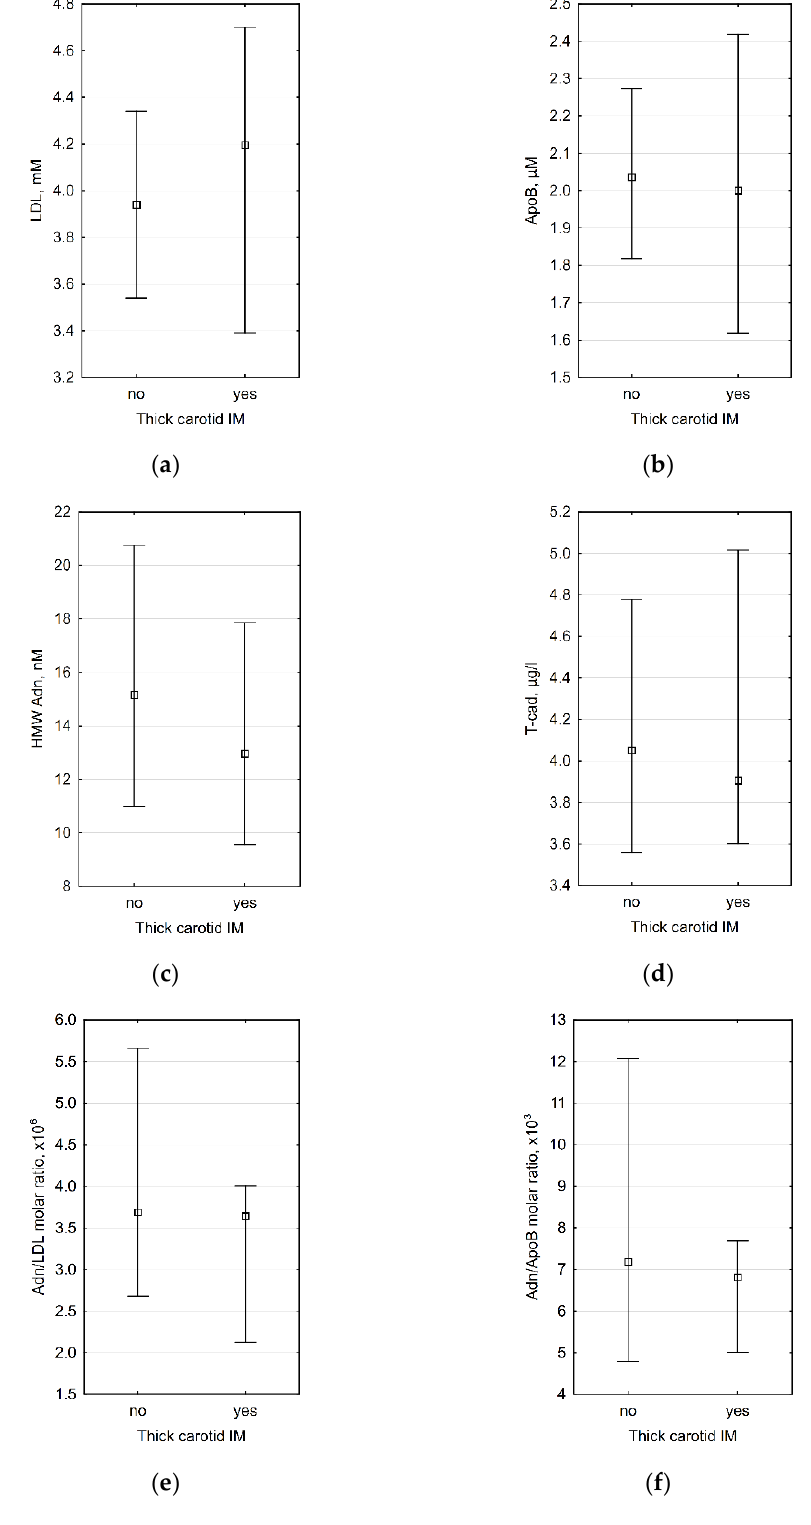
Figure 1. Association between presence of thick (>0.9 mm) carotid intima-media complex and ( a ) plasma LDL level ( p = 0.661), ( b ) plasma ApoB level ( p = 0.711), ( c ) plasma HMW adiponectin level ( p = 0.469), ( d ) plasma T-cadherin level (0.853), ( e ) HMW adiponectin/LDL molar ratio (0.578), and ( f ) HMW adiponectin/ApoB molar ratio ( p = 0.625). n = 35 for all diagrams.